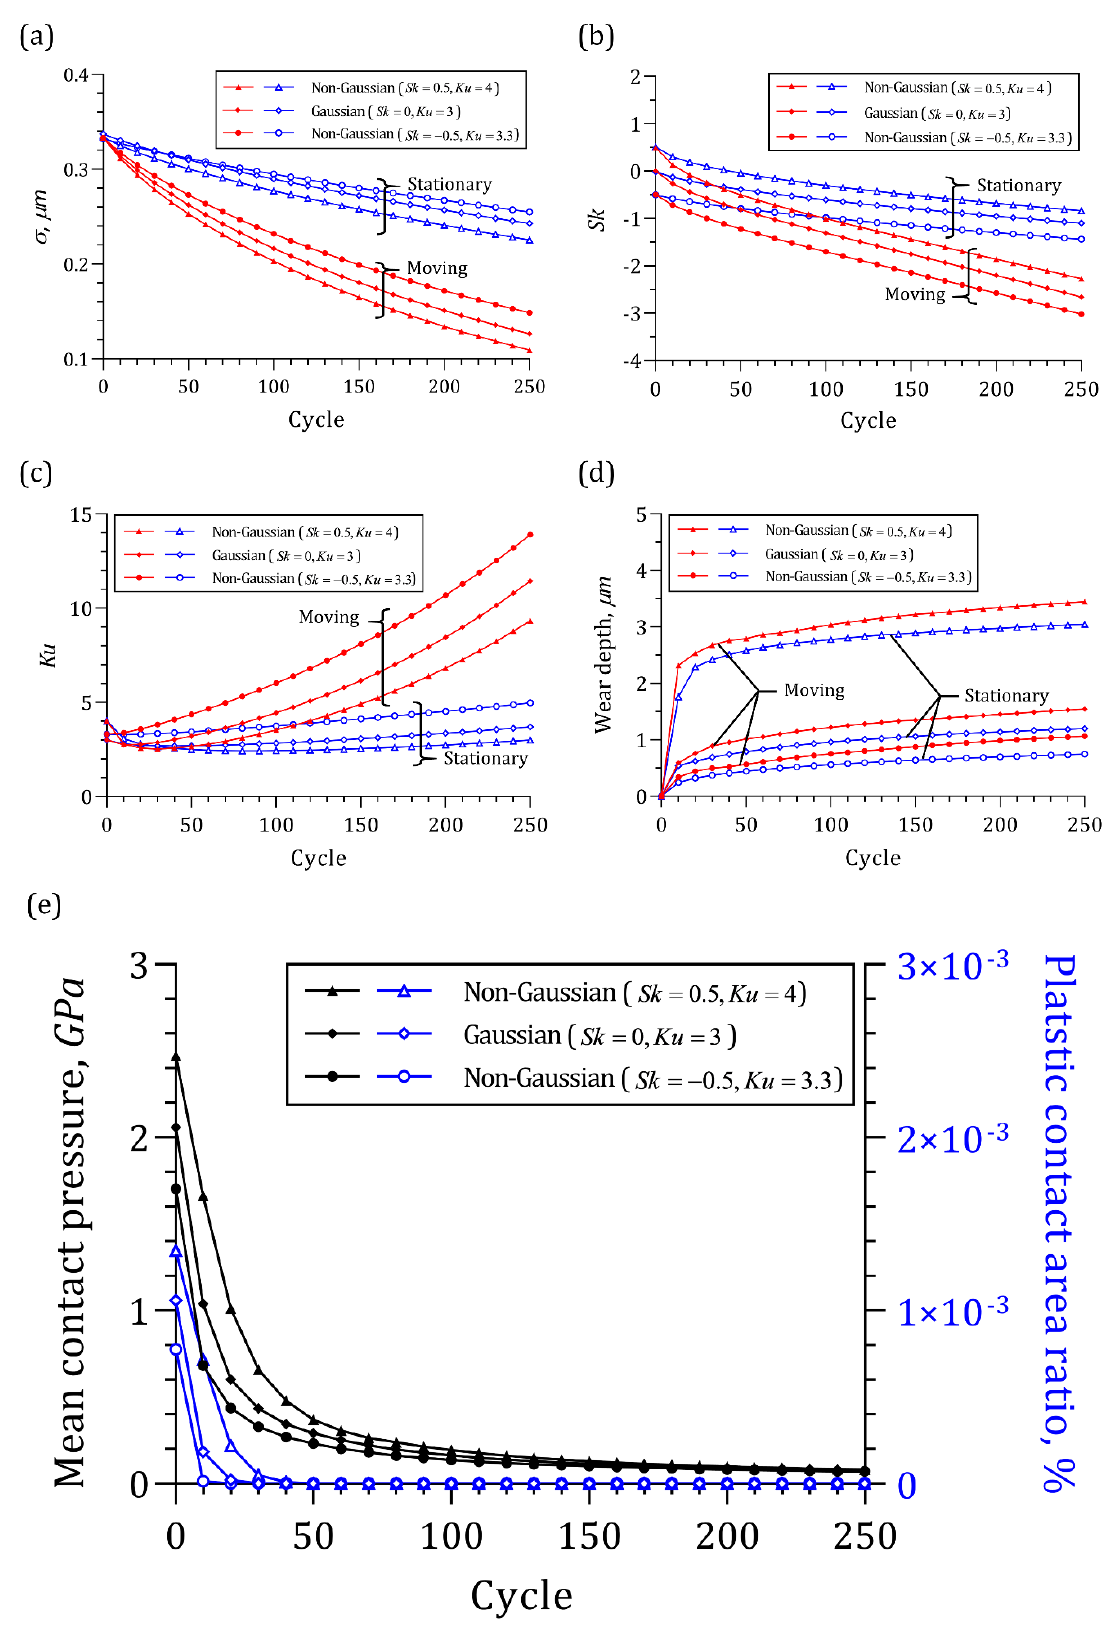
Figure 10. Parameters vs. wear cycle: ( a ) RMS roughness; ( b ) skewness; ( c ) kurtosis; ( d ) wear depth; ( e ) mean contact pressure and plastic contact area ratio.